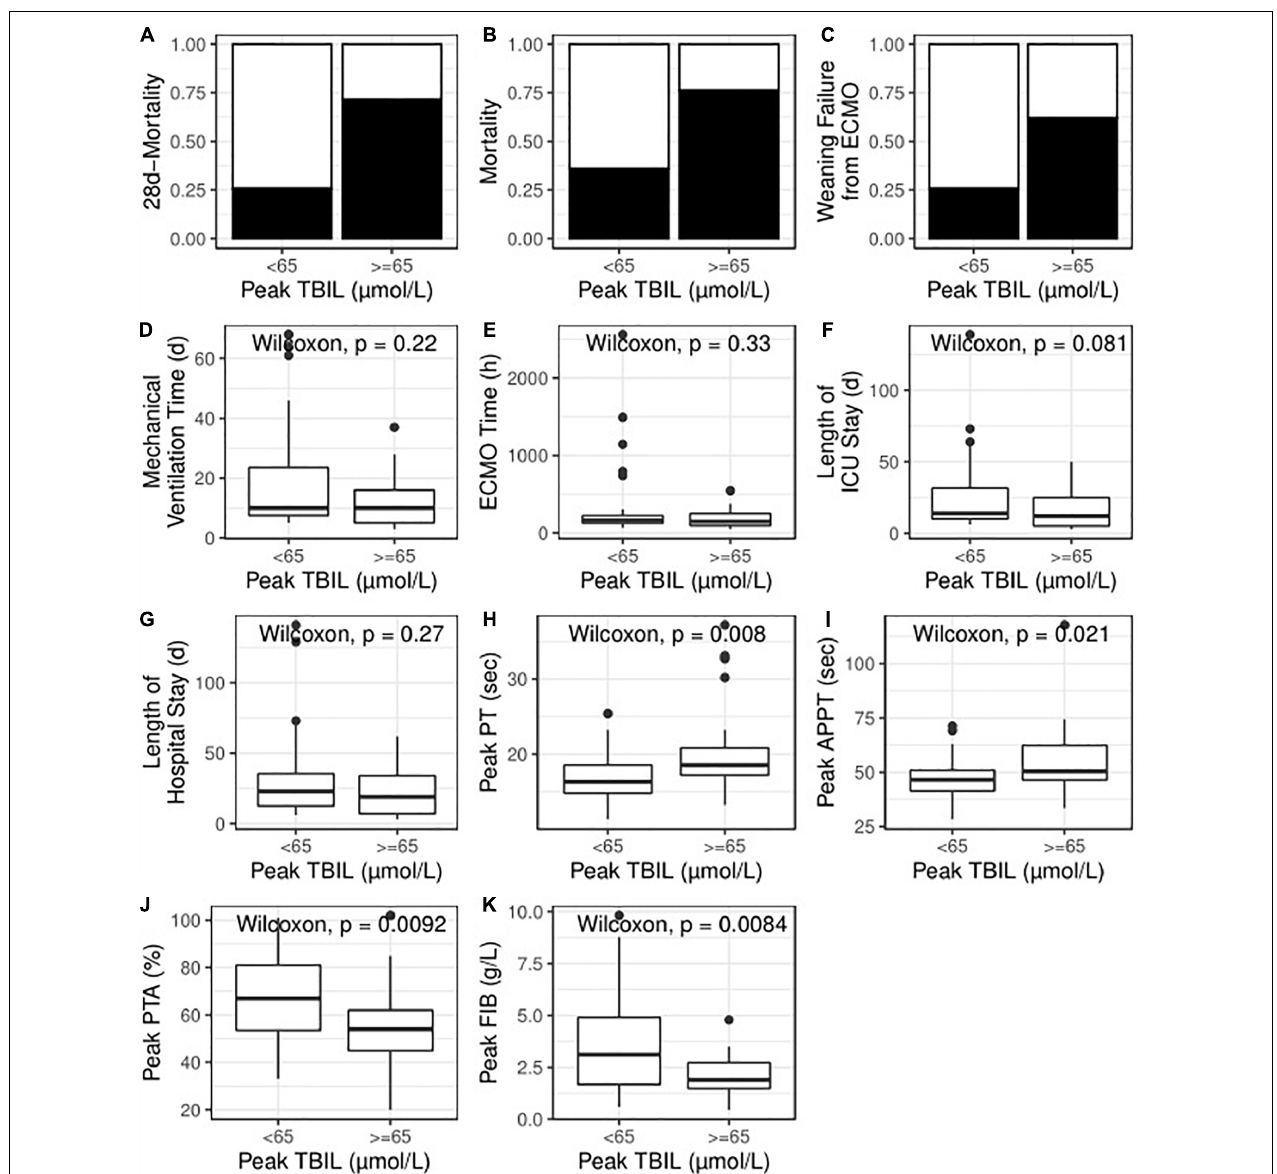
FIGURE 3 | High TBIL during ECMO indicated poor primary outcome (A,B) , poor secondary outcome (C–G) and abnormal coagulation function (H–K) . TBIL, total bilirubin; ECMO, extracorporeal membrane oxygenation; ICU, intensive care unit; PT, prothrombin time, APTT, activated partial thromboplastin time; PTA, prothrombin time activity; FIB,